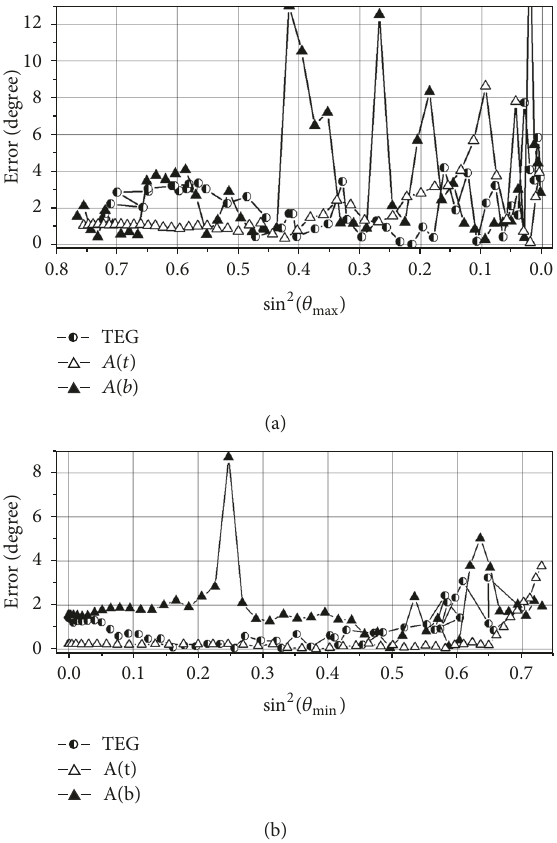
Figure 13: Error for the asymmetric set of azimuths and noise, variant 𝑉 𝑃3 = 3200 ; (a) fixed 𝜃 min and (b) fixed 𝜃 max